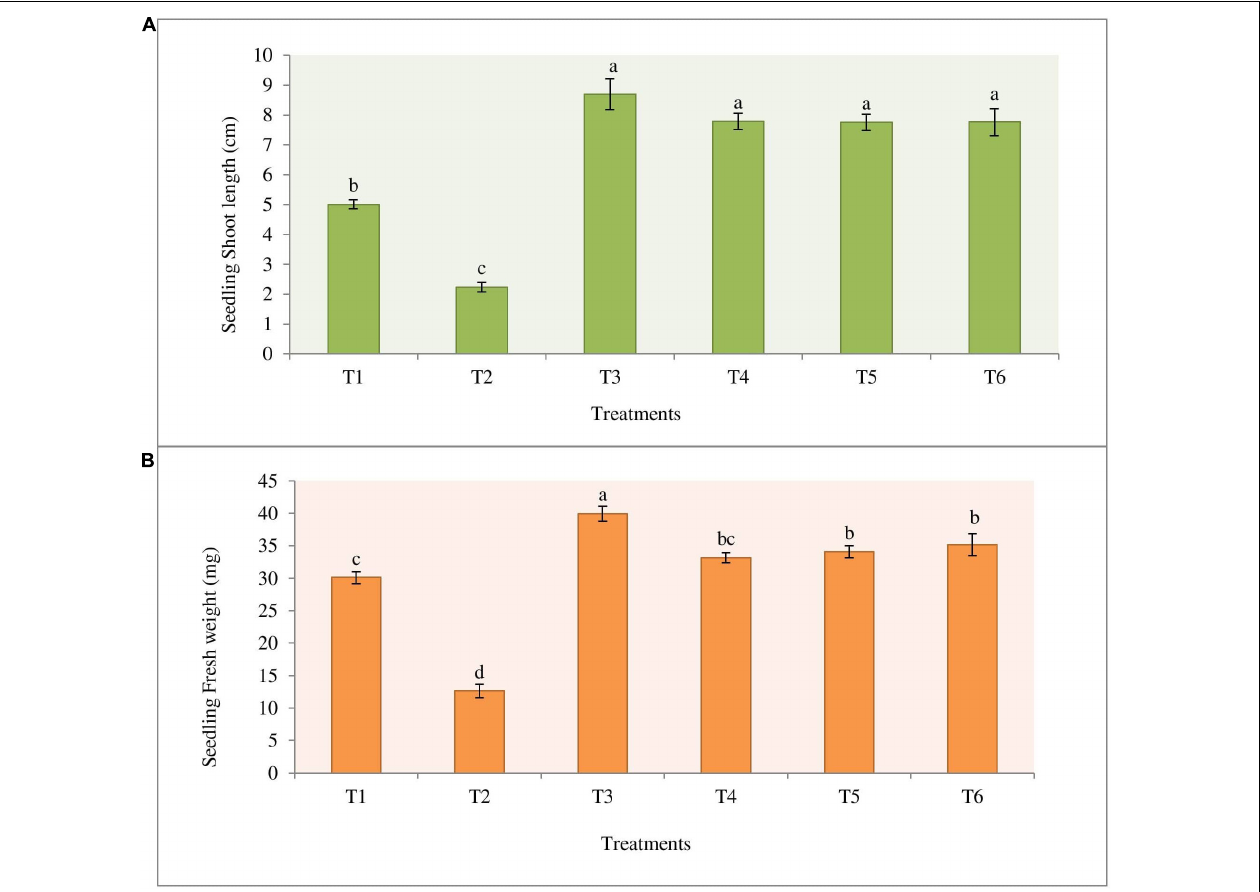
FIGURE 9 | Effect of priming of tomato seeds with strain NKIT9 on the (A) shoot length of the seedling ( F = 54.109; df = 53) and (B) seedling fresh weight ( F = 70.928; df = 53). Evaluation was made after 15 days of planting of tomato seeds. Nine replicates were used for the assay with 10 seedlings in each replicate. Bars labeled with the same letters are not significantly different according to Duncan Multiple Range Test at p = 0.05. Vertical lines represent the standard errors of the